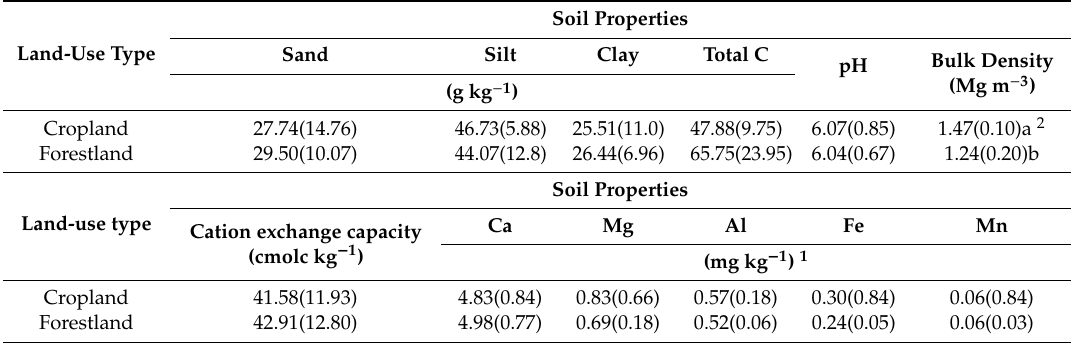
Table 1. Soil properties in the 0–10 cm layer of selected cropland and forestland in shelterbelt systems in central Alberta. Standard deviations are given in parenthesis ( n = 6).